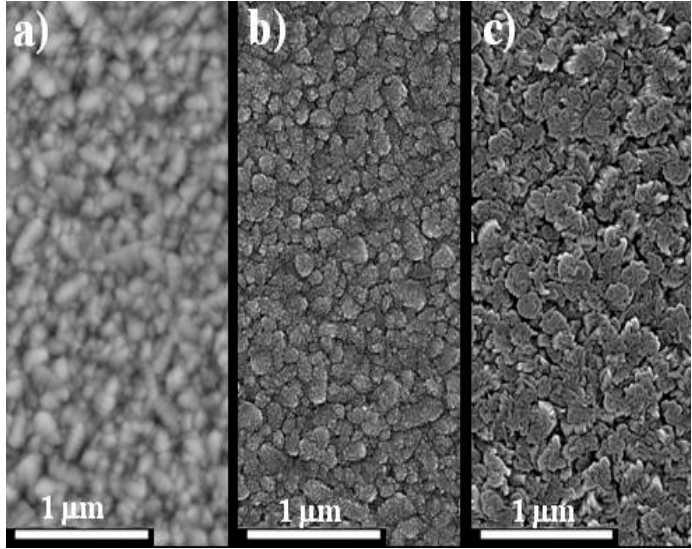
Figure 5. Top view SEM images of the individual layers. ( a ) u-SnO 2 ; ( b ) CdS; and ( c ) CdTe films.